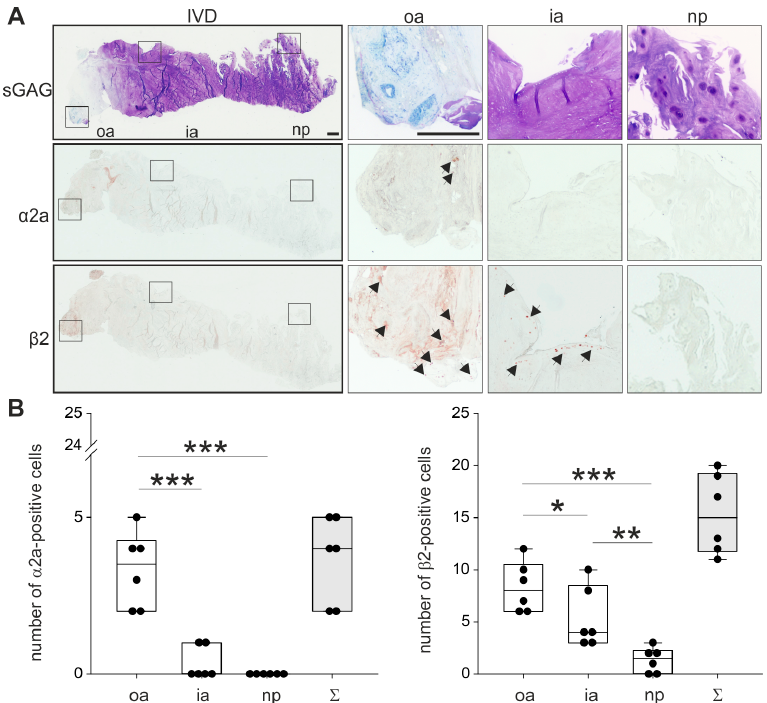
Figure 3. Localization and distribution of ARs. ( A ) Immunohistochemical analysis of the most prominent ARs ( α 2a-AR and β 2-AR, black arrows) in human IVD sections (bars 500 μ m). Squares in the left panel represent further magnified regions shown to the right ( n = 3). ( B ) The number of α 2a- and β 2-positive cells in human IVD tissue ( n = 3). Each black circle represents the number of α 2a- or β 2-positive cells per section of an individual patient (2 sections per patient analyzed). Data are presented as box plots, which are described in the legend to Figure 2. Significant p -values are presented as * p < 0.05, ** p < 0.01, or as *** p <